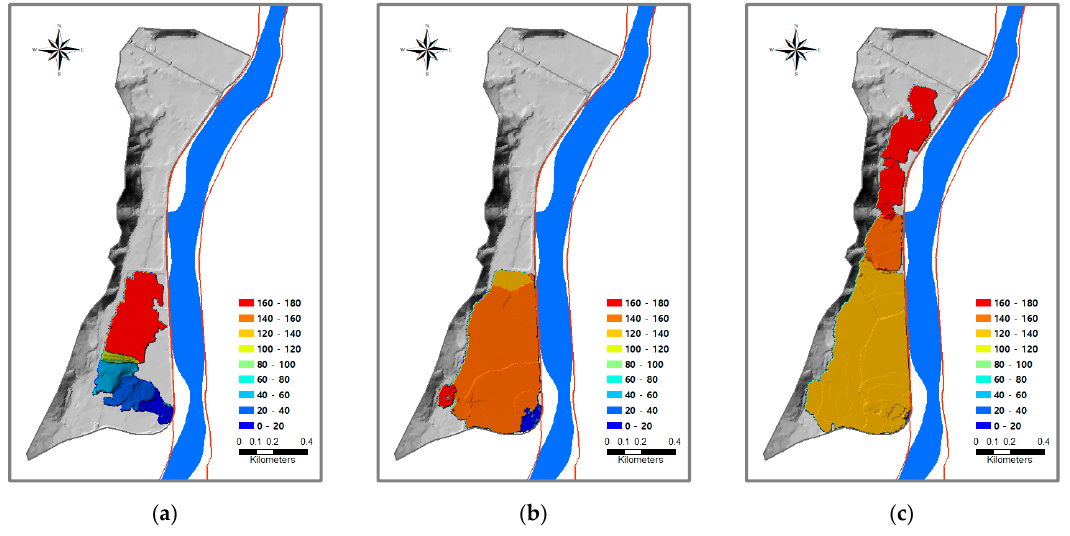
Figure 11. Maximum velocities for Levee #1 failure case, ( a ) LV1-1, ( b ) LV1-6, ( c ) LV1-9.